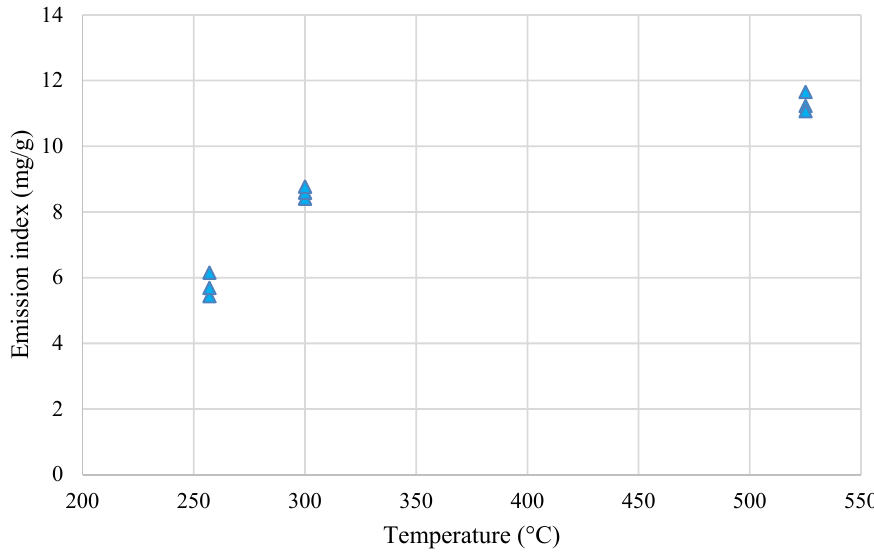
Figure 17. Emission index for the Miscanthus torrefaction process using an electric oven.